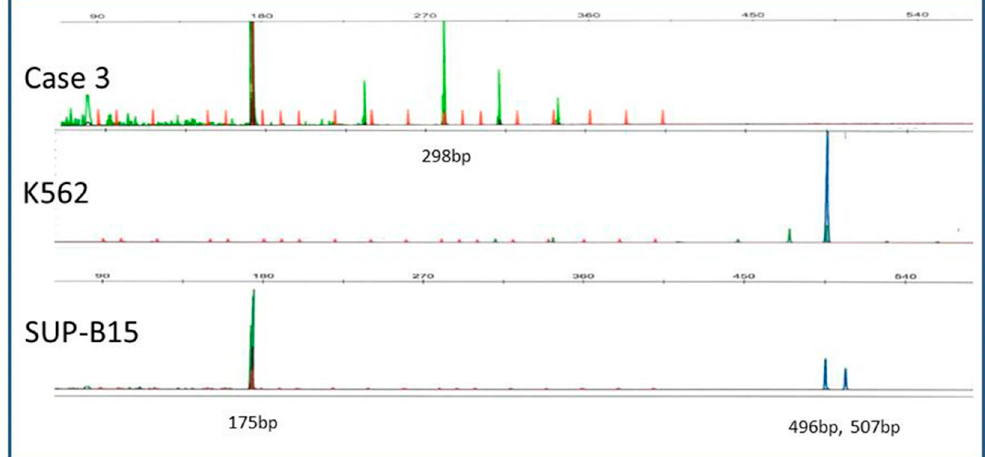
Figure 1. Detection of Ik-6, Ik-8, and other transcripts by size-fragment analysis. Multiplex RT-PCR with hexachlorofluorescein (HEX)-labeled (Ik-6/8 product) and 6-carboxyfluorescein (FAM)-labeled (IKT product) primers was performed using capillary electrophoresis. The samples included K562, SUP-B15 and an ALL sample (Case 3 or 3565. Table 1). Ik-6 and Ik-8 PCR products were detected at 175 bp and 298 bp, respectively. Other peaks in the ALL sample likely represent non-specific peaks or lower-level RNA isoform species but were not further characterized. The normal C-terminal IKT product was detected at 496 bp in K-562, with an additional abnormal 507 bp detected in SUP-B15, which was confirmed by DNA sequencing to represent a 14-base pair insertion (see text). Table 1. Screening of IKZF1 isoforms expressed in ALL